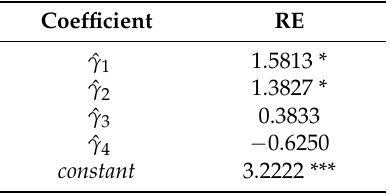
Table 3. The effect of the different tokens and delay on contributions.